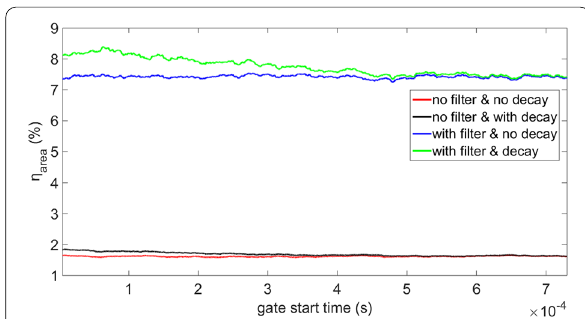
Figure 6 Diffuse field verification on white noise with or without filter and decay using metric η